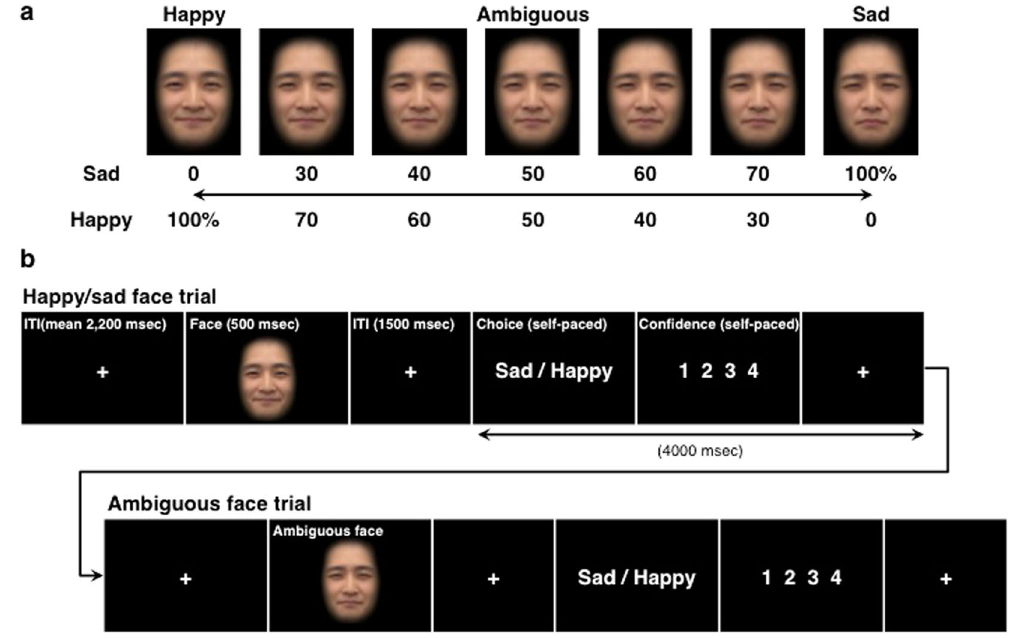
Figure 1. Face stimuli and the two-alternative forced choice task. ( a ) Representative example of the graded emotional facial expression stimuli used in the task, ranging from a 100% happy face to a 100% sad face. For the purpose of presentation, these example images were constructed by morphing the laboratory members and were not used in this experiment. ( b ) Two-alternative forced choice task. Ambiguous face trials were preceded by either “happy” or “sad” face trials. ITI: inter-trial